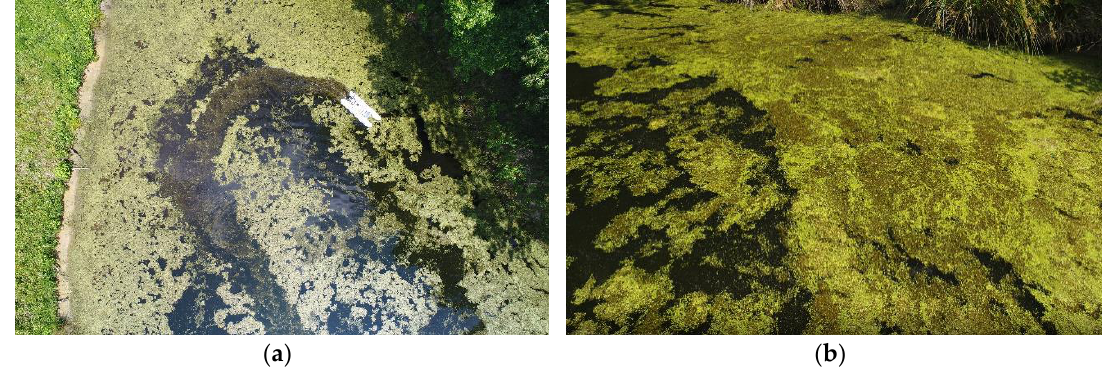
Figure 1. Watermeal infestation in a central North Carolina pond: ( a ) aerial view; ( b ) ground view.